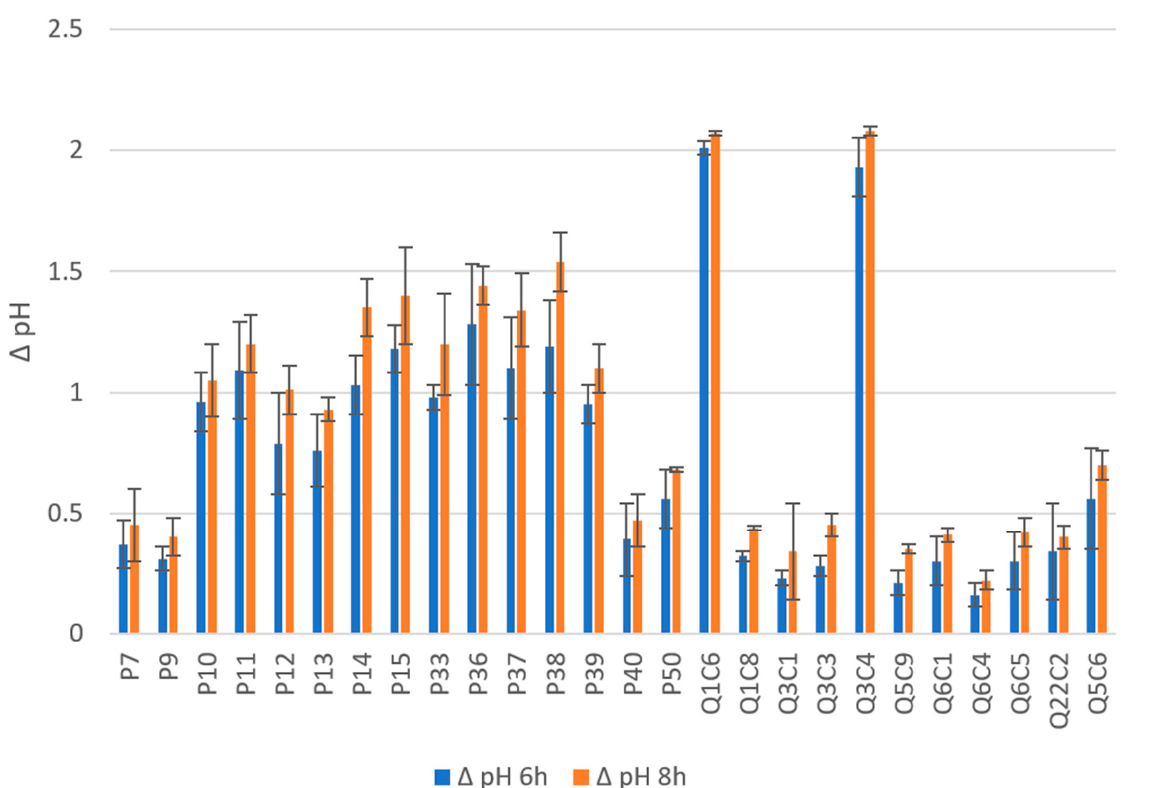
Figure 1. Acidifying activity of LAB strains. Results are expressed as ∆ pH (6 h and 8 h) (starting from a pH of 6.7) and reported as mean and standard deviation of three